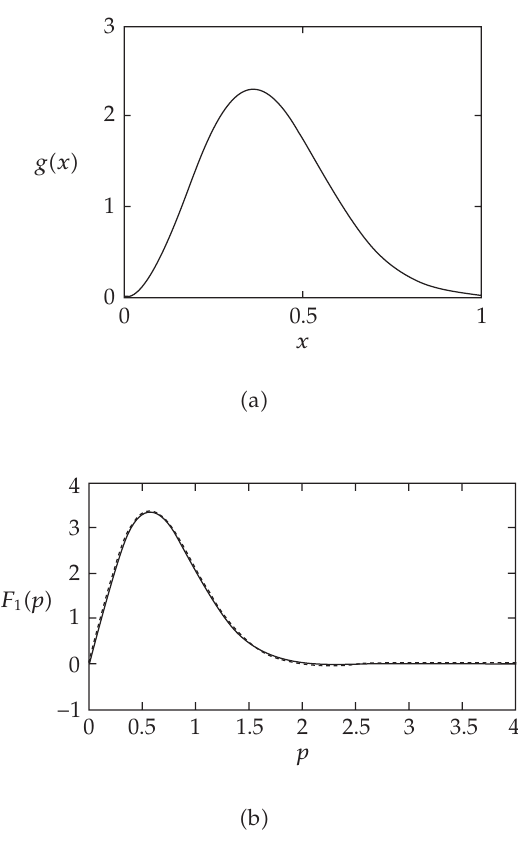
Figure 1 . ( a ) Original function and ( b ) Hankel